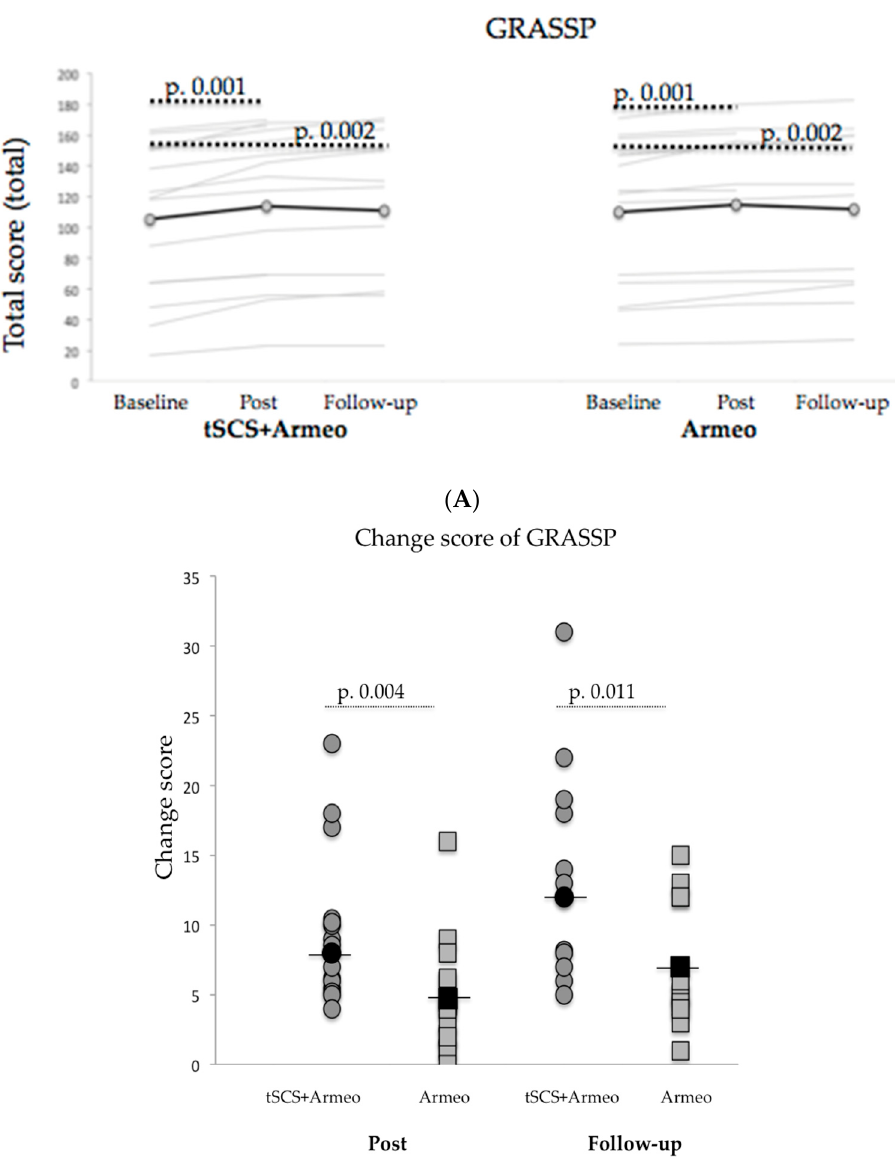
Figure 2. ( A ): GRASSP scores. Thin grey lines represent each subject and a thick black line is the mean of the group. The p -value according to the Wilcoxon test; ( B ): Changes scores of GRASSP, and p -value according to Mann-Whitney U test. The grey circles represent the change score of each subject in the intervention group and squares in the control group. Black circles and squares are the mean of the